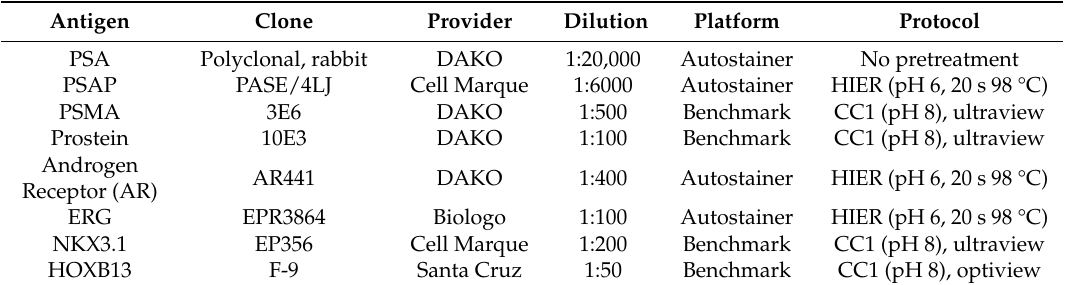
Table 2. Antibodies used for immunohistochemistry in this